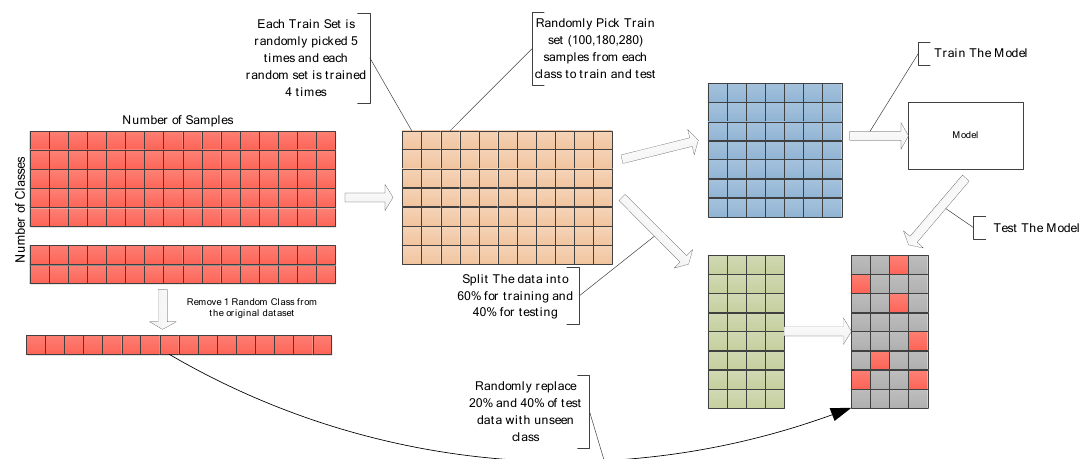
Figure 14. Performance evaluation based on various numbers of training samples over the unseen class.